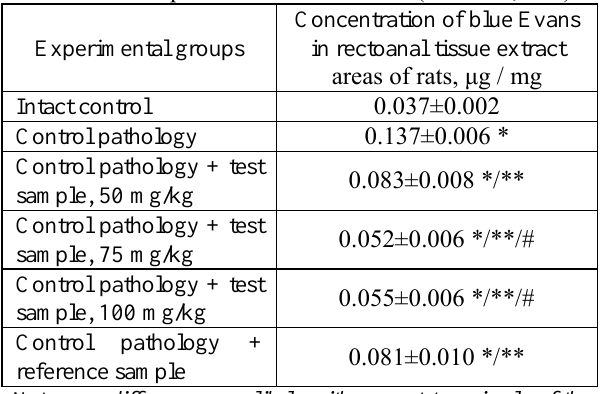
Fig. 3. Release profile of active pharmaceutical ingredients